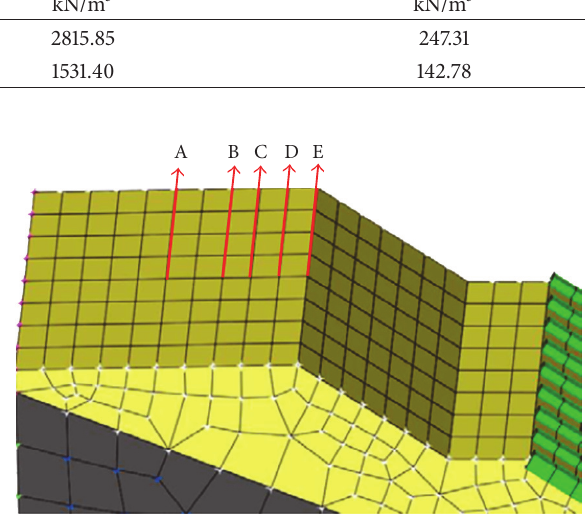
Figure 9: Characteristics point schematic diagram.